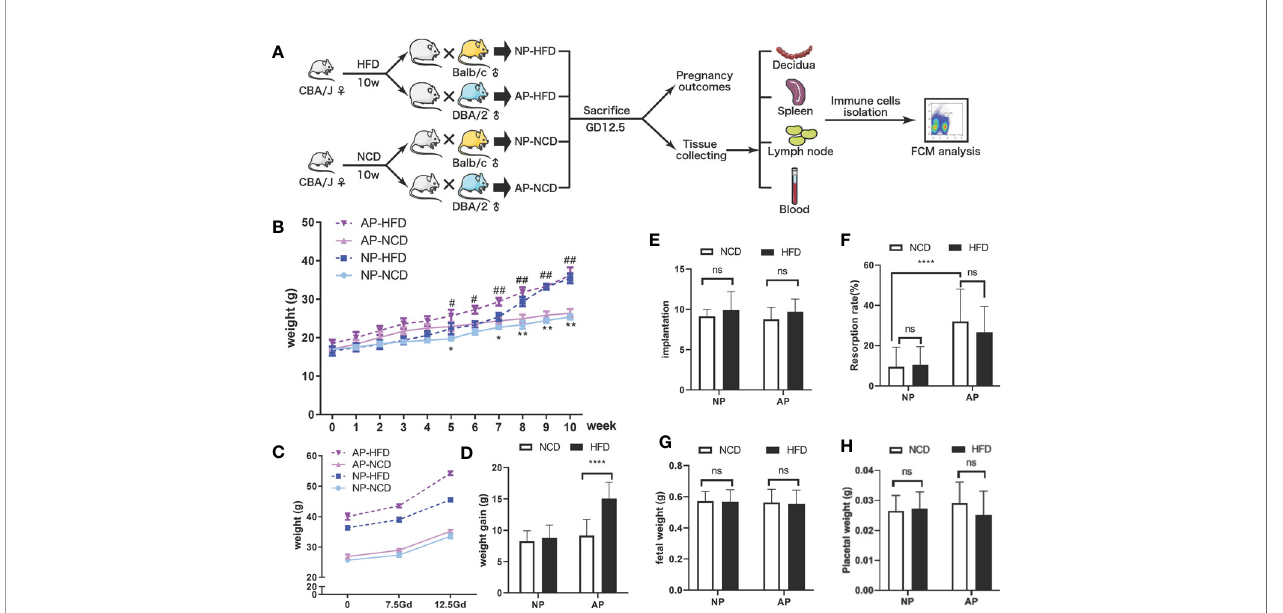
FIGURE 1 | Effects of HFD on weight gain and pregnancy outcomes in normal and abortion-prone mouse models. (A) Schematic diagram showing the experimental design of the mouse models involving the establishment, gestational termination at GD12.5, pregnancy outcomes observation, immune cell isolation and analysis. Mouse weights during normal pregnancy (NP, dark and light blue) or spontaneous abortion (AP, dark and light purple) were measured from start of the experimental diet, on either a high-fat diet (HFD, dotted line) or a normal chow diet (NCD, solid line) before mating (B) and during gestation (C) . (D) Maternal weight increments during gestation on GD12.5. All dams were killed on GD12.5, and the implantation numbers (E) , resorption rates (F) , fetal weights (G) as well as placental weights (H) were presented. Data are presented as mean ± SEM. NS, not signi fi cant; *p < 0.05, **p < 0.01, ****p < 0.0001, # p < 0.05, ## p <